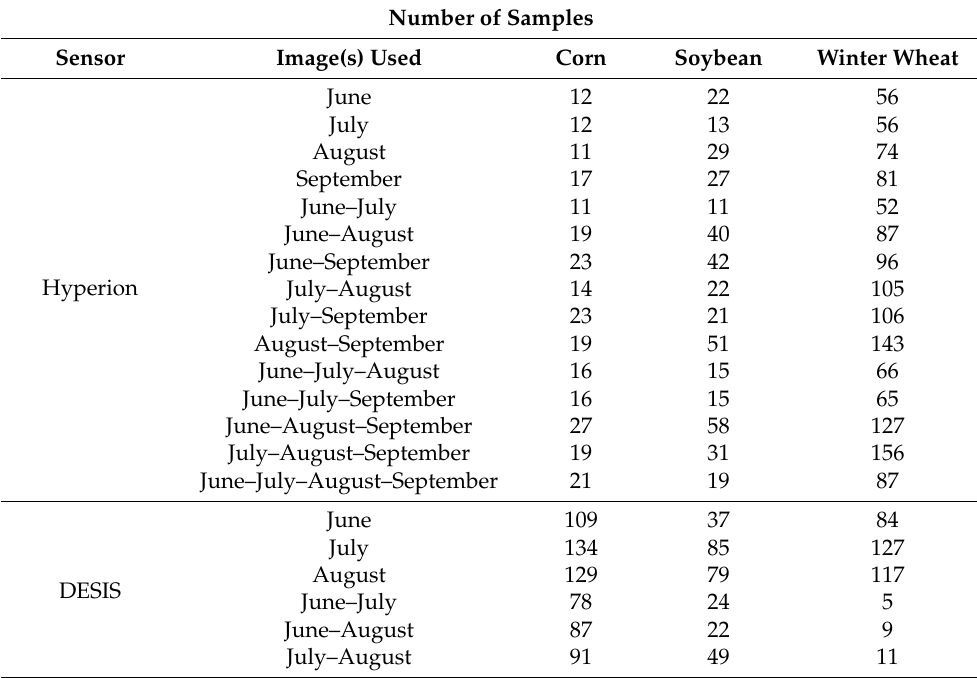
Table 5. Validation samples. Sample sizes in the validation subsets across all years for Hyperion classification analyses (2010, 2012, and 2013), and DESIS classification analyses for 2019. Number of Samples Sensor Image(s) Used Corn Soybean